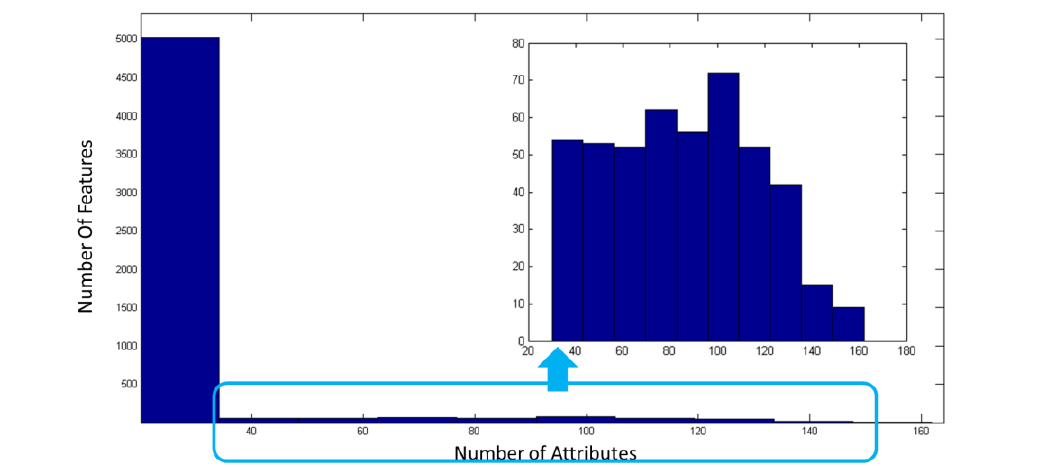
Figure 2 Histogram of the Meaningful Features